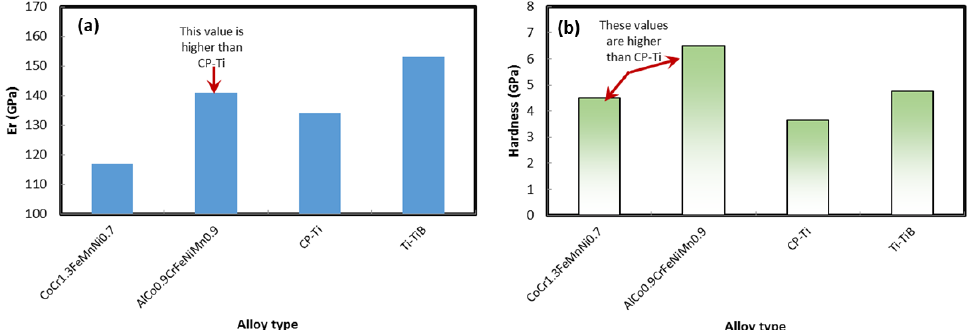
Figure 10. ( a ) A bar chart showing the reduced elastic constant for different HEAs as well as commercially pure Ti and Ti-TiB composite (PBF based). ( b ) A bar chart showing the hardness for different HEAs as well as commercially pure Ti and Ti-TiB composite (PBF based).